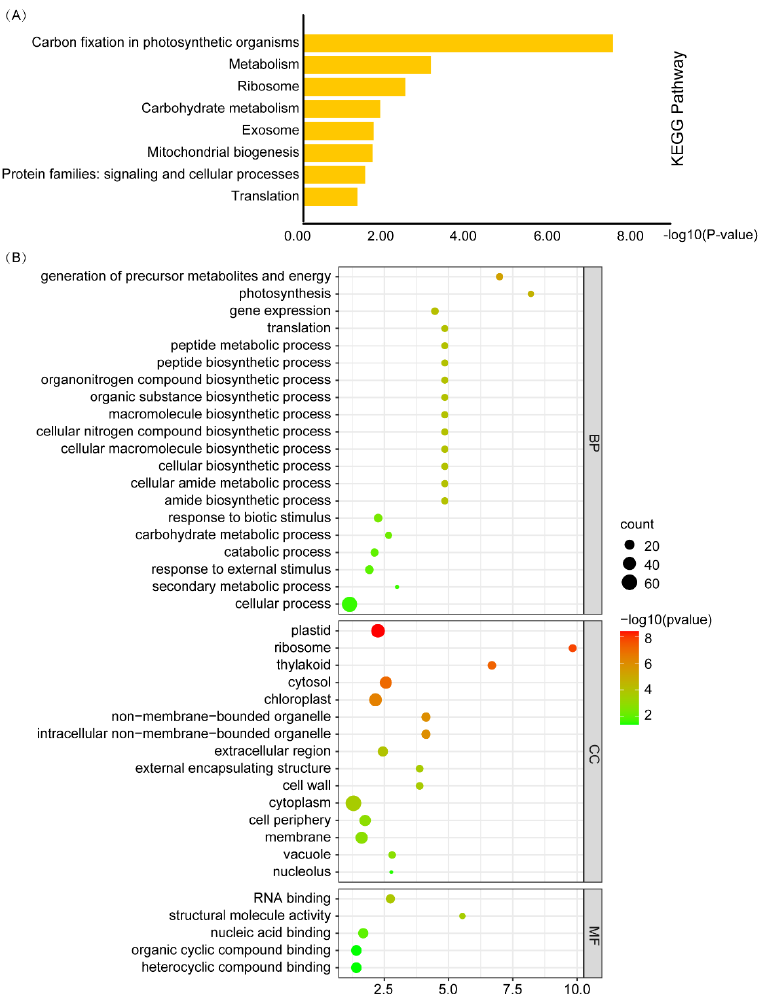
Figure 1. KEGG pathway and GO enrichment analysis of the candidate interactors. ( A ) KEGG pathway enrichment of the StSP6A interactors. ( B ) GO enrichment of the candidate interactors. Each term is represented by a circle node whose size is proportional to the number of input genes falling into the term, and the color represents the − log10 ( p −value).